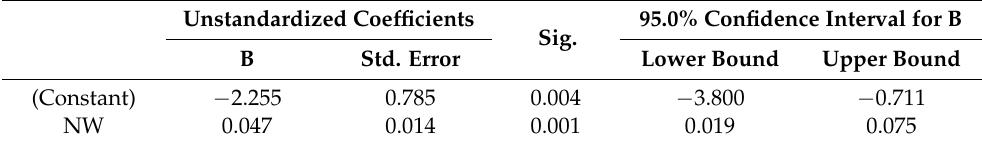
Table 10. NAS simple linear regression model and patient deaths per